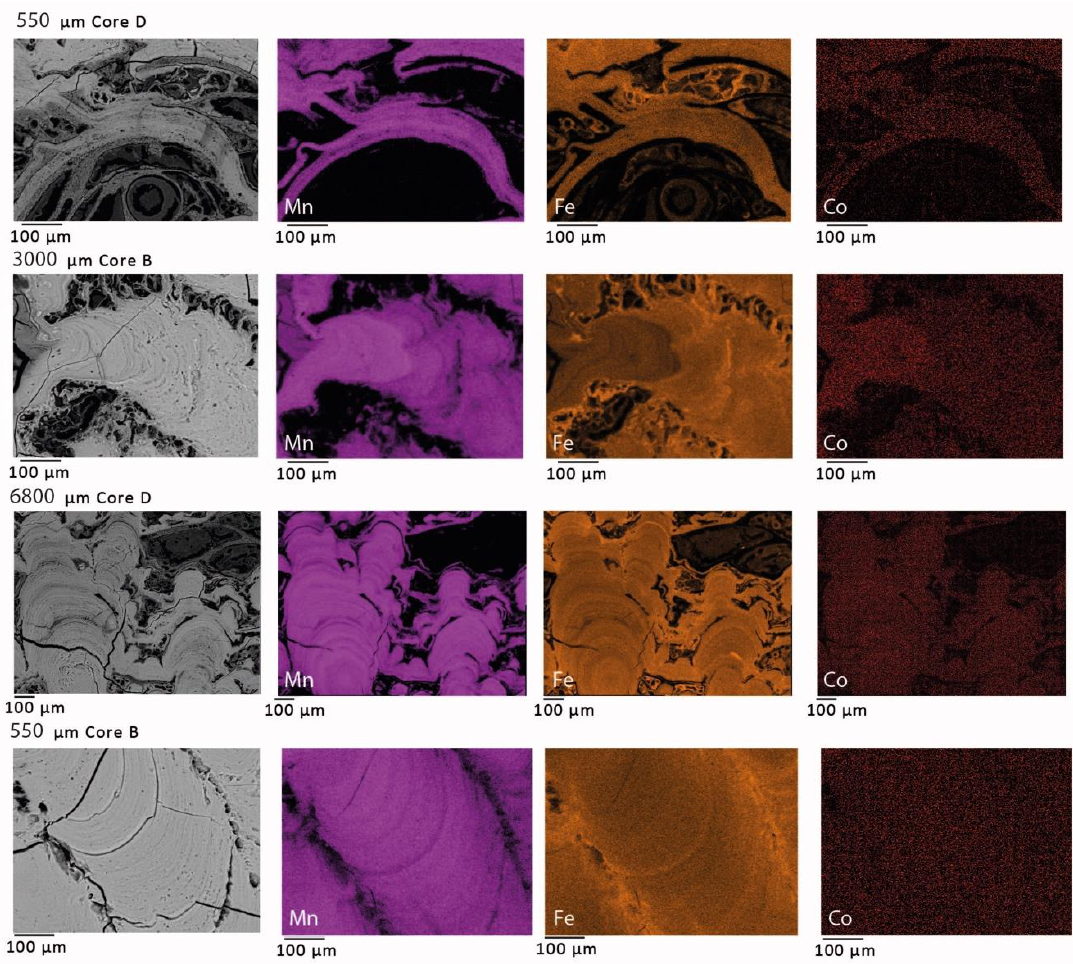
Figure 5. Example SEM-EDS analyses of some characteristic textures and features showing the distribution of Mn, Fe, and Co within them. Brighter colors equal higher concentrations. Mn and Co